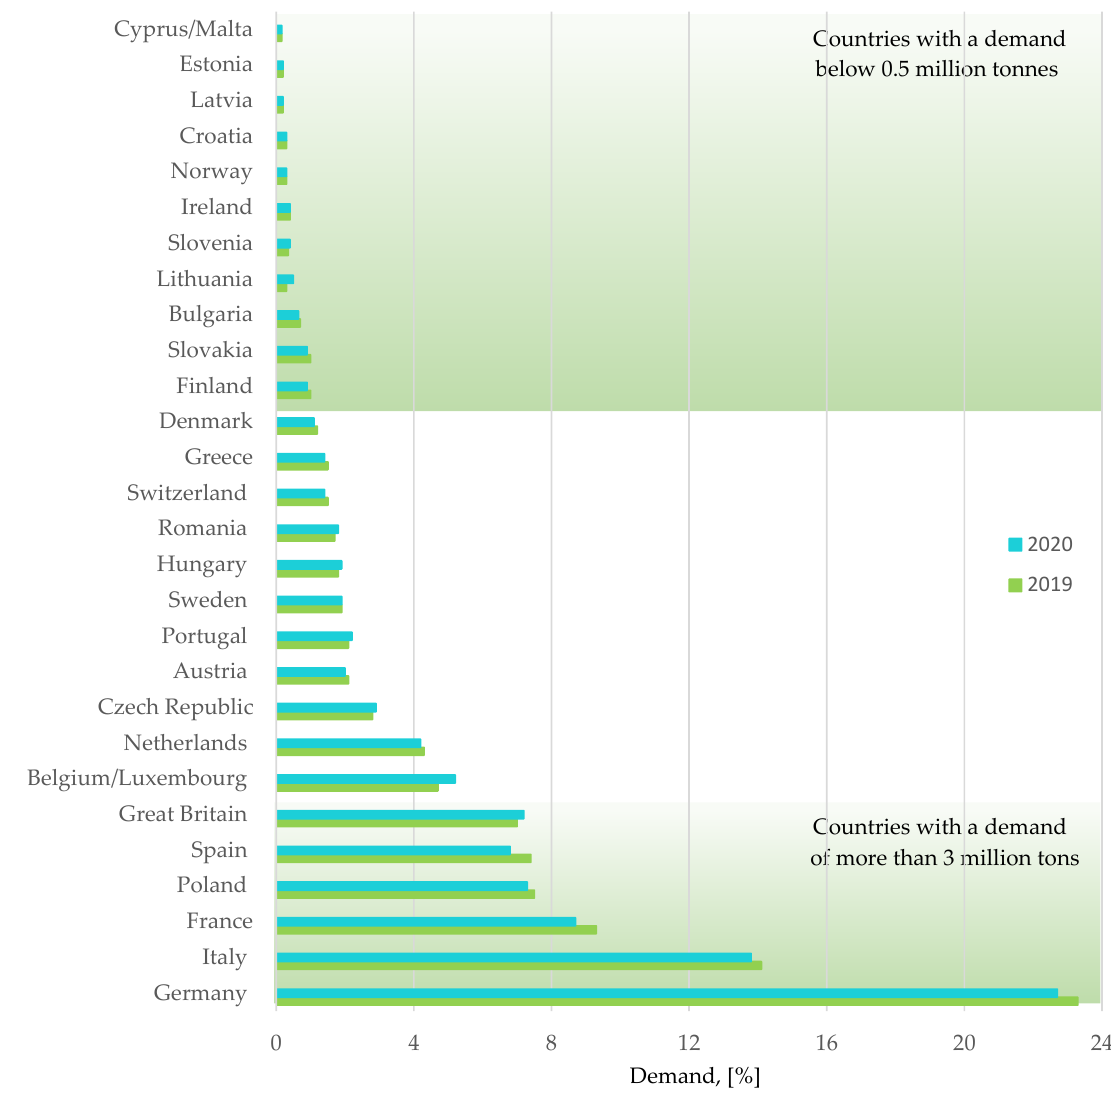
Figure 5. Plastics demand by country. Made based on [3].